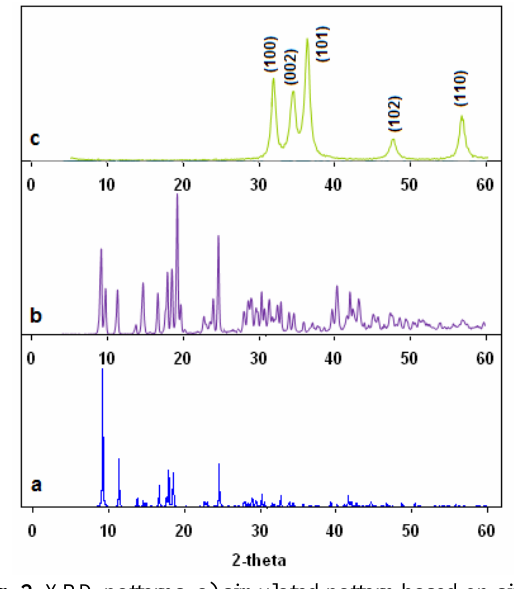
Fig. 2. XRD patterns; a) simulated pattern based on single crystal data of compound [Zn (DMF) ] ( 1 ), b) white precipitate of 1 , c) ZnO 2 n nanoparticles fabricated from calcination of compound 1 .